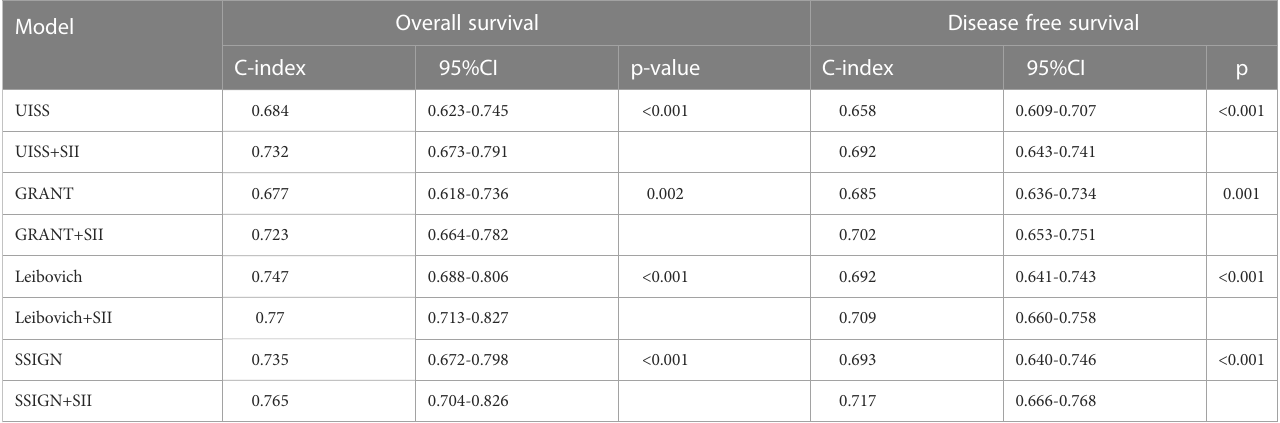
TABLE 5 Improvement of existing model in all patient.